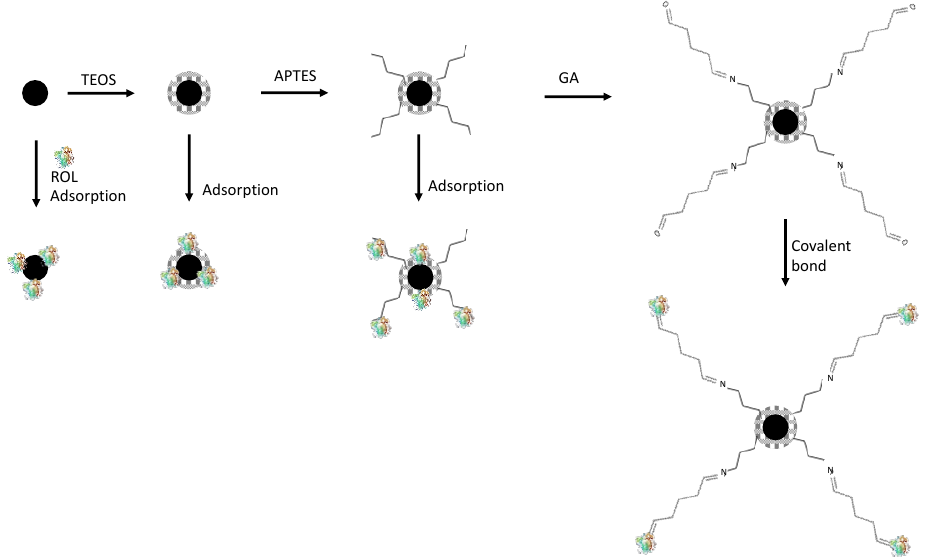
Figure 12. Schematic illustration of functionalization of MNPs with APTES and GA and immobilization of ROL.